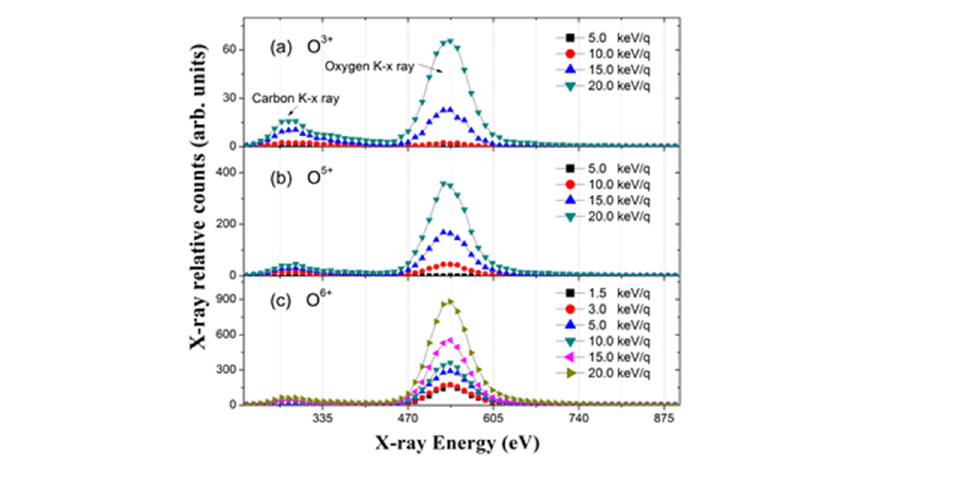
Table 1. Gauss fitting results to the measured X-ray spectra for 10 keV/q oxygen ions with charge state, q, equal to 3, 5, and 6, respectively.